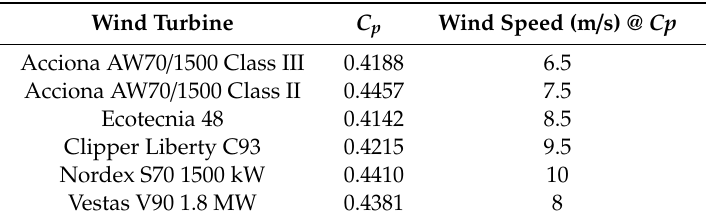
Table 2. Wind turbine C p .